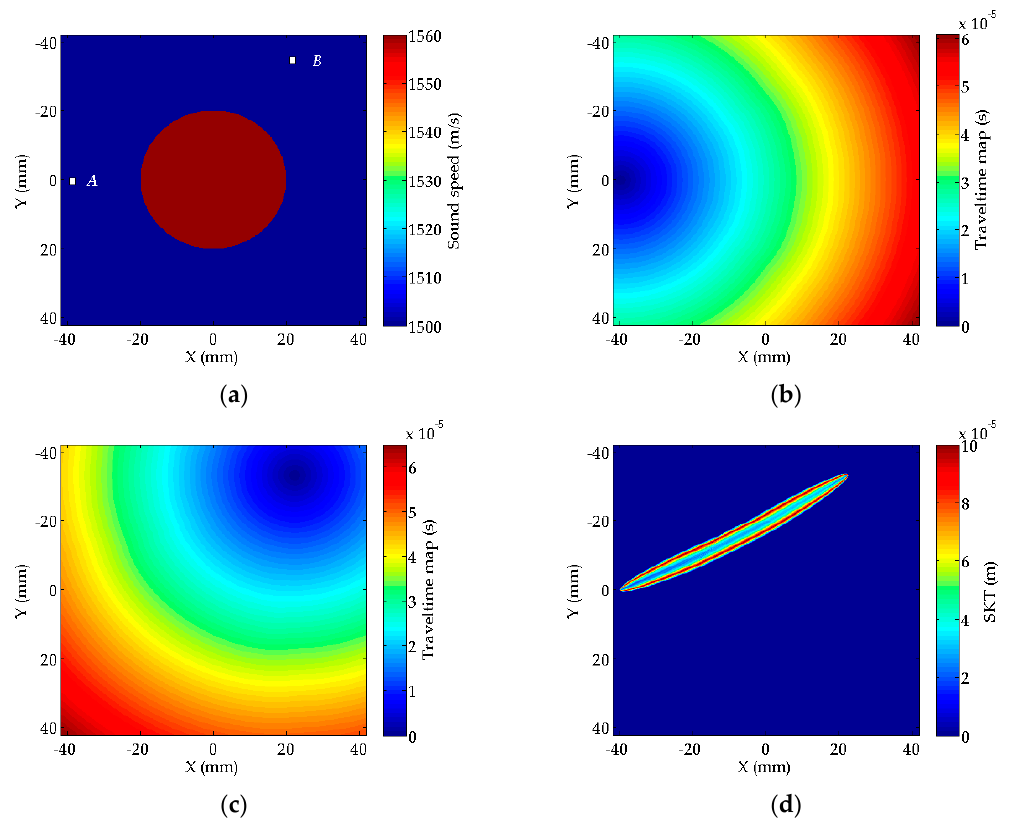
Figure 4. ( a ) A circular phantom immersed in water with a transmitter–receiver pair 𝐴 − 𝐵 ; ( b ) travel- Figure4. ( a )Acircularphantomimmersedinwaterwithatransmitter–receiverpair A − B ; ( b )travel-time time map originated from transmitter 𝐴 ; ( c ) travel-time map originated from receiver 𝐵 ; ( d ) the SKT map originated from transmitter A ; ( c ) travel-time map originated from receiver B ; ( d ) the SKT between between transmitter 𝐴 and receiver 𝐵 calculated by Equation (7). transmitter A and receiver B calculated by Equation